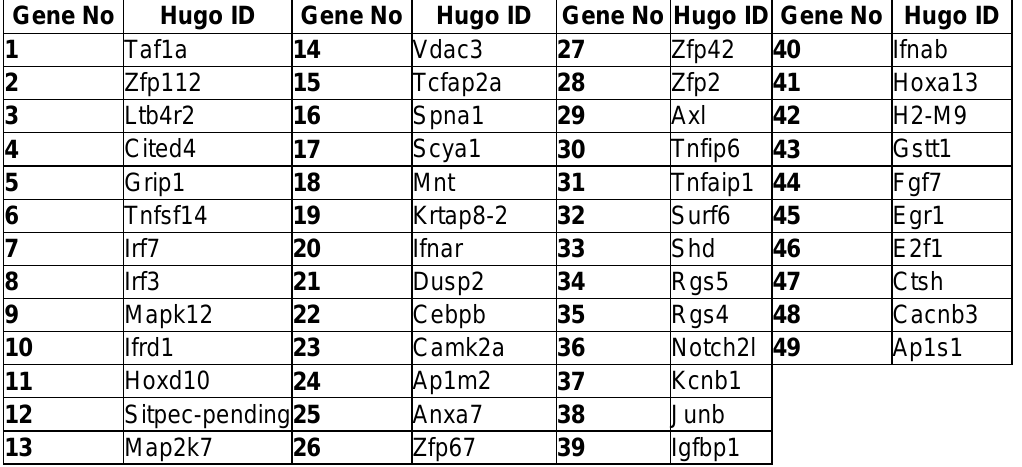
Figure 5: Genes upregulated in both in-vitro and in-vivo studies investigating the molecular events underlying T cell anergy common genes. Amongst them we identified Egr1 alongside the transcription factors Irf3 and supplemental Figure